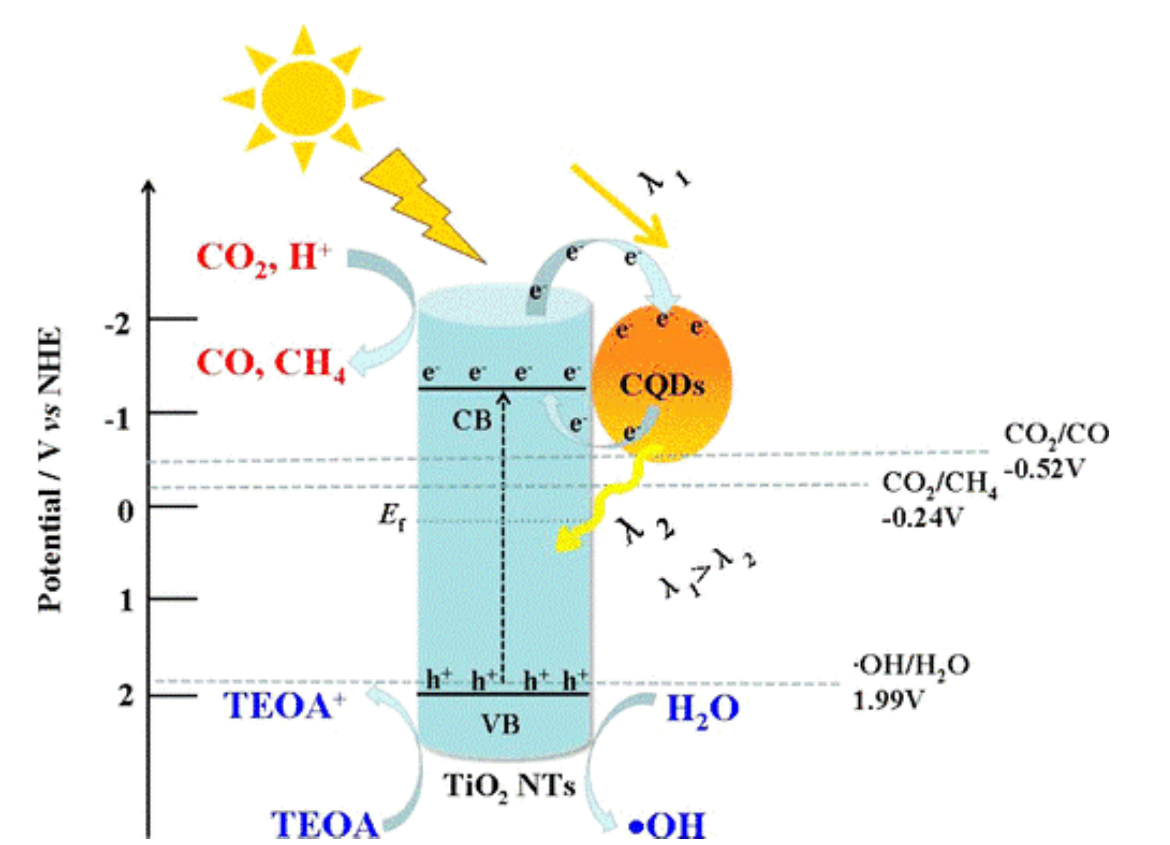
Figure 10. Photocatalytic CO 2 reduction mechanism over CQD-modified TNTs, retrieved from [17].